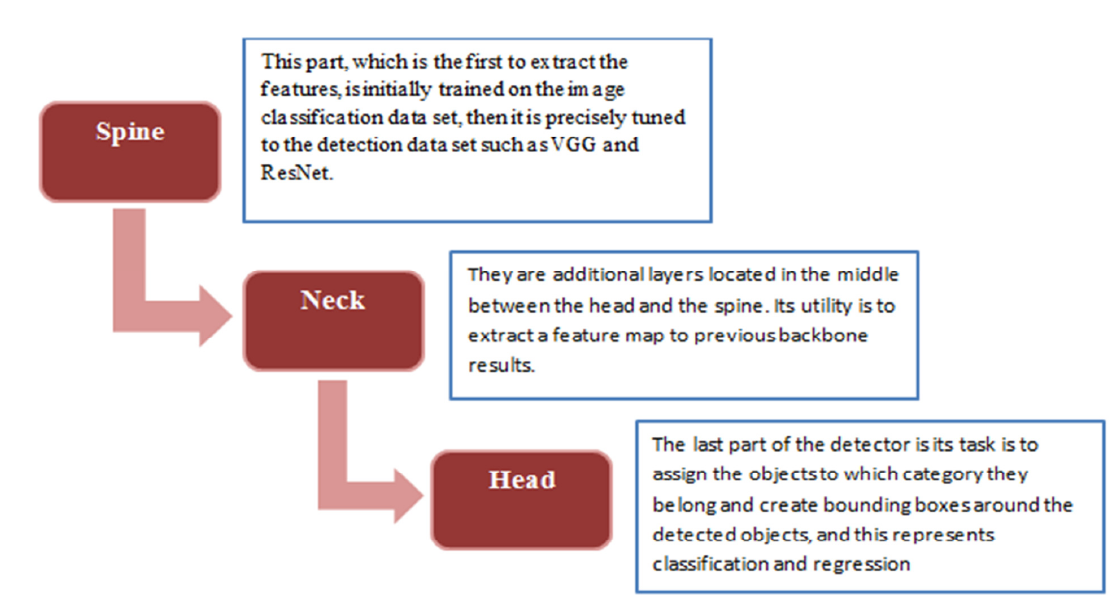
Fig. 2. General architecture of object